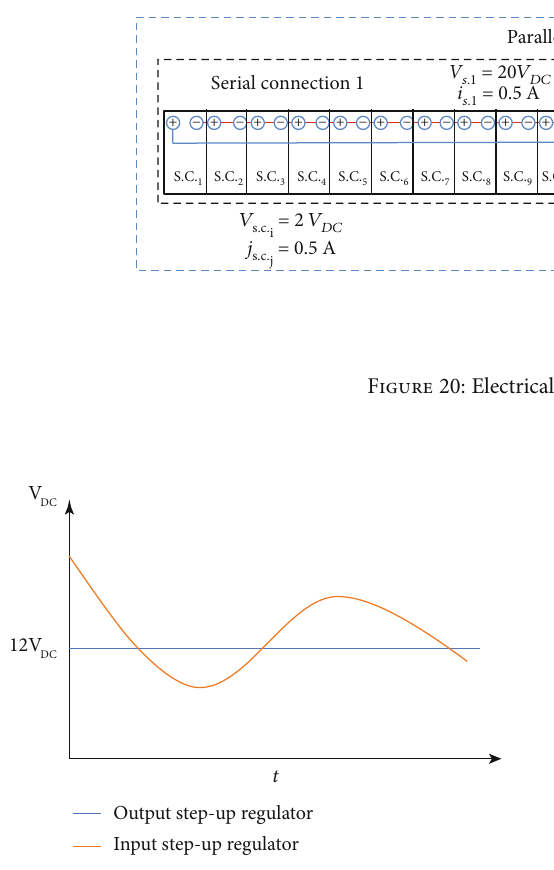
Figure 21: Voltage regulation of the step-up.